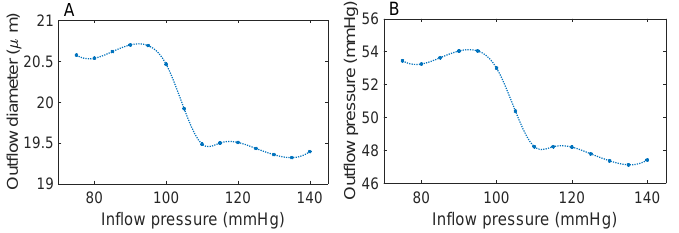
Figure 9. Predicted ( A ) steady-state diameter (time- and space-averaged across all cells); and ( B ) time- averaged outflow pressure (for the last afferent arteriole cell), for a range of luminal pressure pulses.